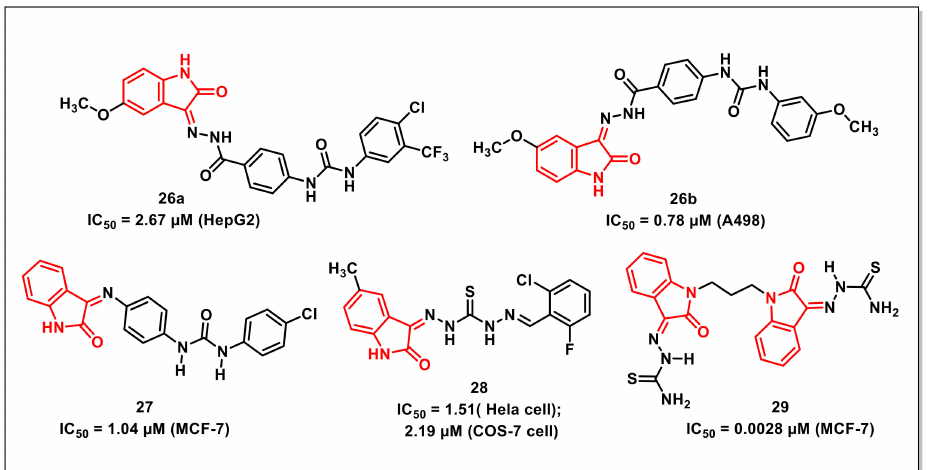
Figure 5. Urea/thiourea-based isatin compounds with anticancer